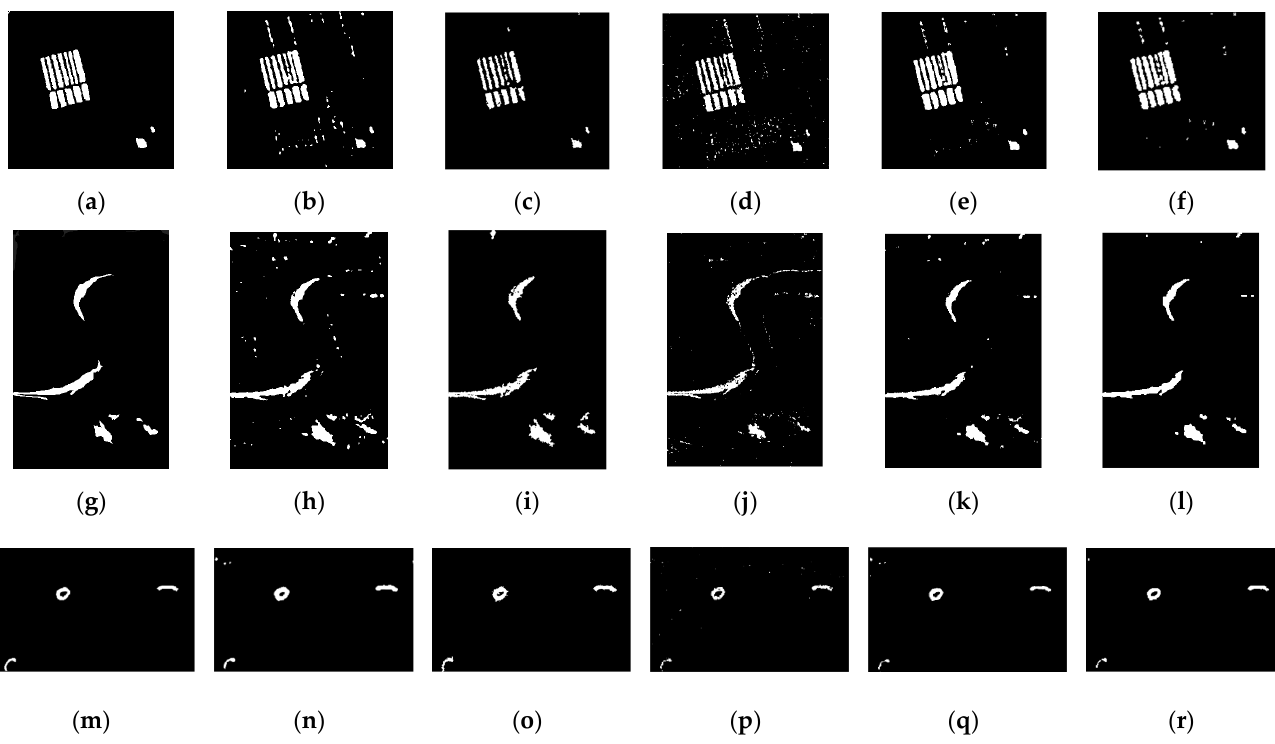
Figure 6. depicts the change maps obtained by four comparative methods in three SAR image data sets. Farmland data set: ( a ) ground truth; ( b ) PCA- k means; ( c ) CWNN; ( d ) DBN; ( e ) JDBN; ( f ) g Γ -DBN. River data set: ( g ) ground truth; ( h )PCA-